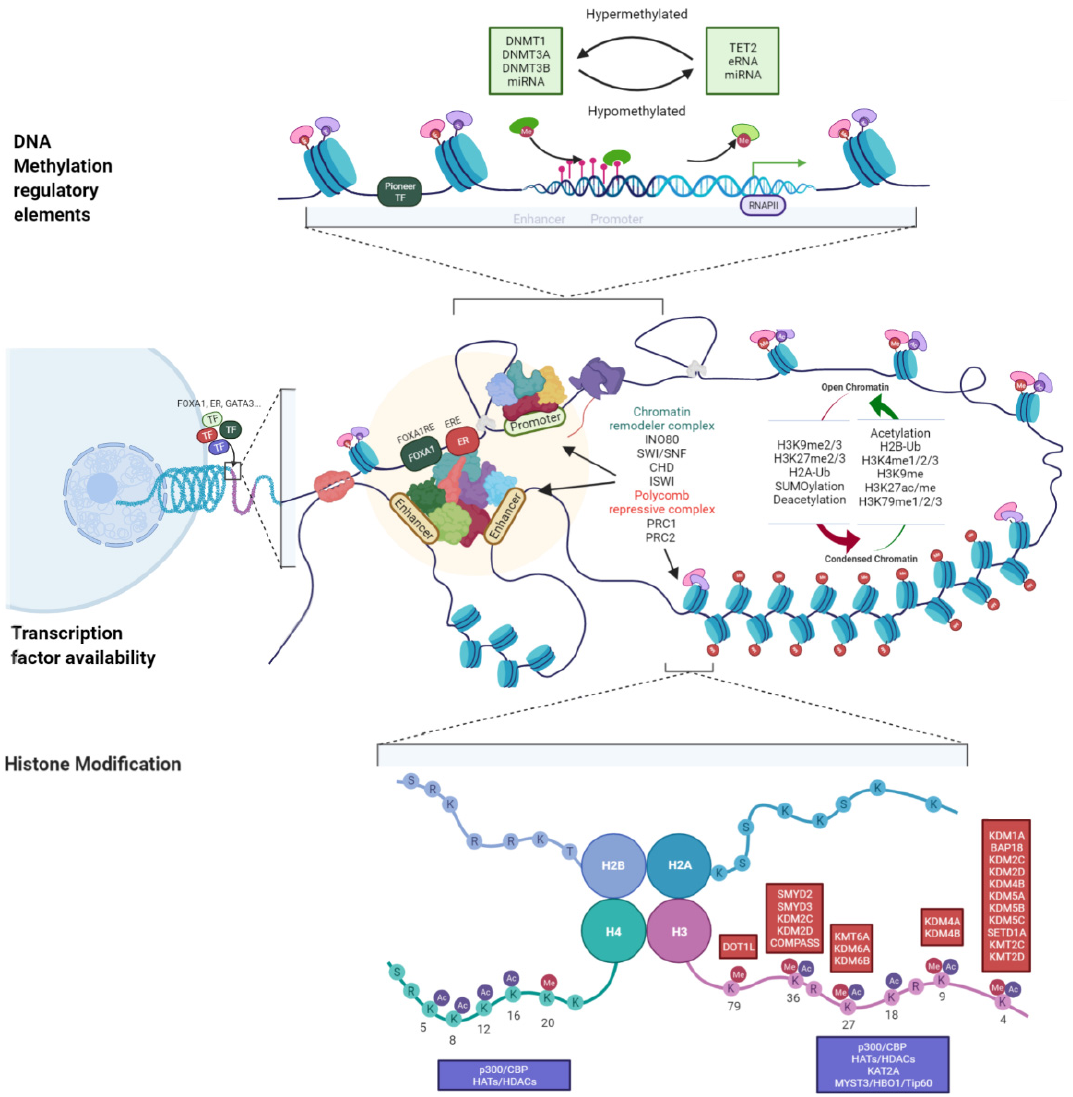
Figure 1. Epigenetic regulation in estrogen receptor signaling. Estrogen receptor-alpha (ER α )- related epigenetic changes in luminal breast cancer. Aberrant regulation of ER α alters the func- tion/expression of coregulators, pioneer transcription factors (such as FOXA1), and epigenetic factors regulating DNA methylation, histone modification, and non-coding RNAs in luminal breast cancer. TF, transcription factor; ERE, estrogen response element; FOXA1RE, FOXA1 regulatory element; RNAPII, RNA polymerase II; S, Serine; R, Arginine; K, Lysine; T, Threonine; Me, methylation; Ac, acetylation; H, histone. The figure is created by the BioRender